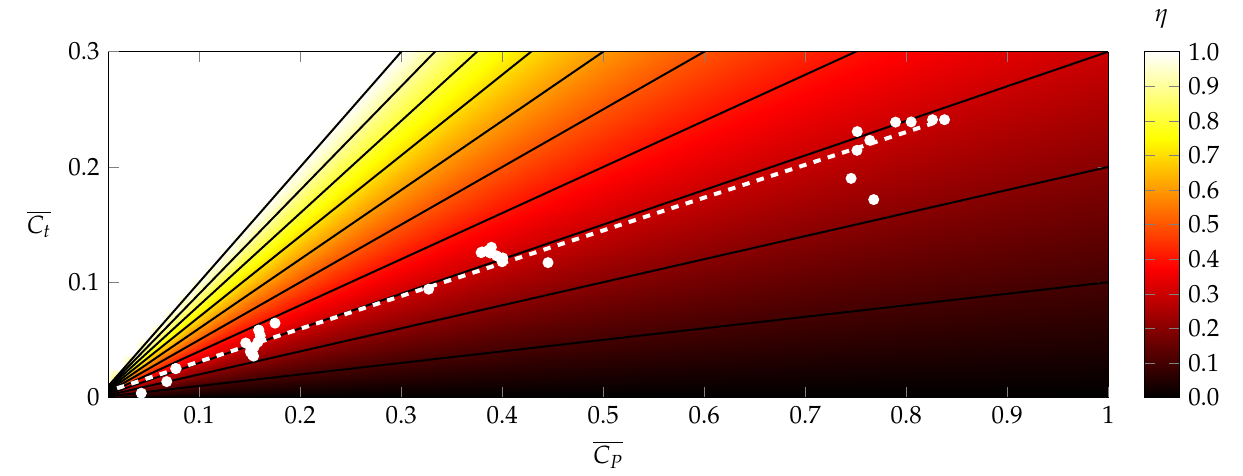
10 4 . Propulsive efficiency is given by the contour ×